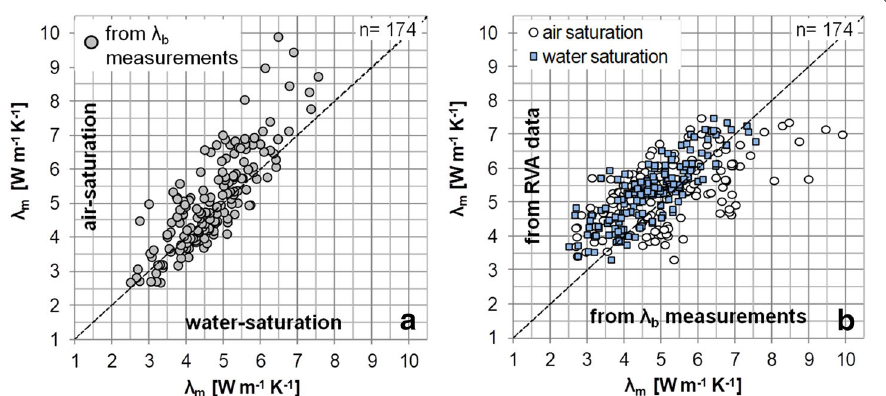
Fig. 4 a Comparison of calculated matrix thermal conductivities ( λ m ) from bulk rock measurements under air-saturated versus water-saturated conditions. b Comparison of calculated matrix thermal conductivities ( λ m ) from mineralogical composition data (RVA) versus λ m calculations from bulk rock measurements ( λ b ) under air-saturated and water-saturated